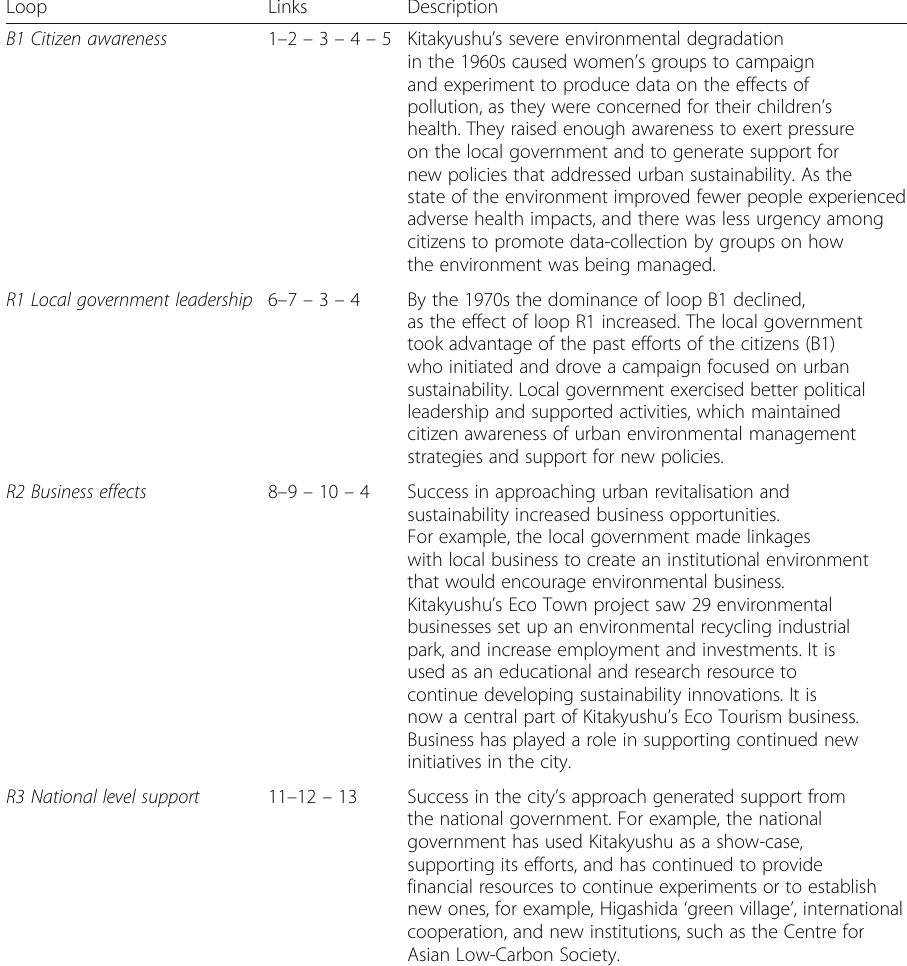
Table 4 Explanation of links and loops from internal activities shown in Fig. 1. Urban environmental degradation triggered action whereby the city supported an approach, which in time brought support from the national government